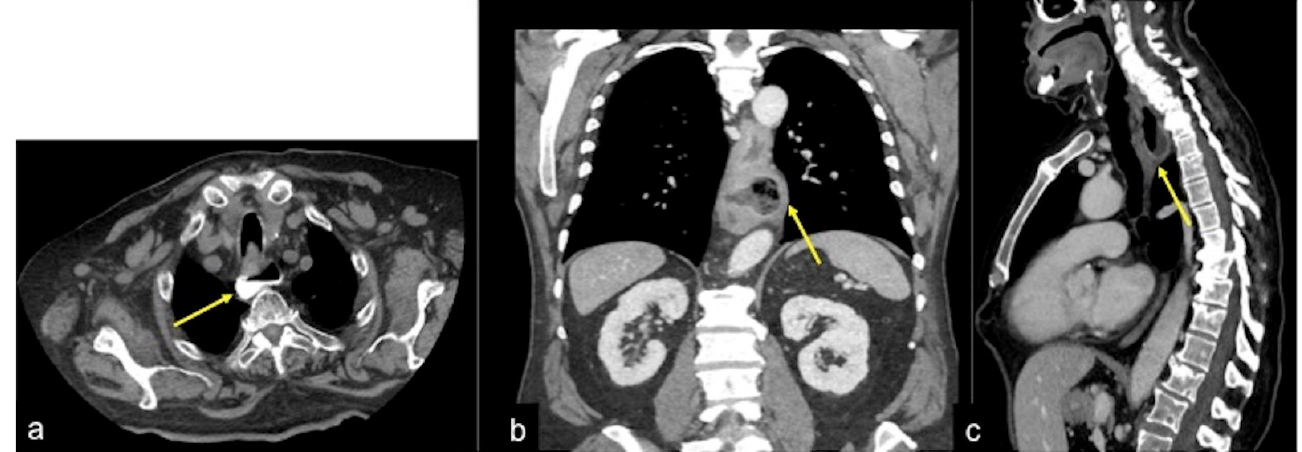
Figure 24. Oesophageal diverticula. Axial ( a ), coronal ( b ) and sagittal ( c ) images of the CTA multiphasic study show a wall protrusion in the middle oesophagus with mucosal hyperaemia as a possible site of bleeding ( a – c , arrow).